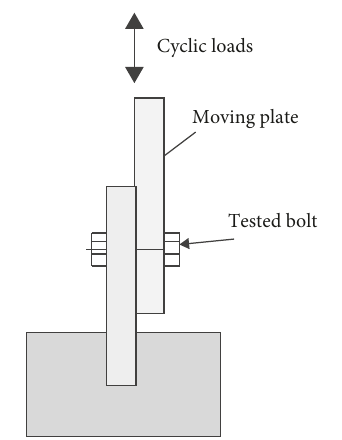
Figure 3: Test device sketch.